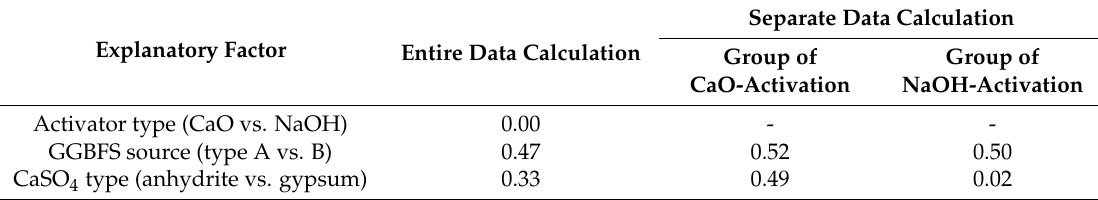
Separate Data Calculation Group of Group of CaO-Activation NaOH-Activation